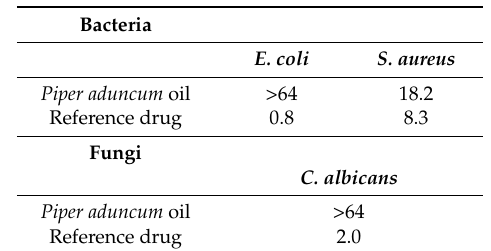
Table 2. Antimicrobial activity, IC 50 ( μ g/mL) of the essential oil from Piper aduncum L. collected in Havana, Cuba.